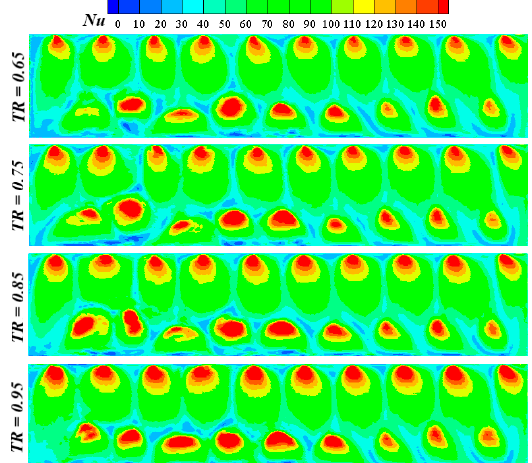
Figure 15. Local Nusselt number on the target surface of the compound cooling unit at different TR .